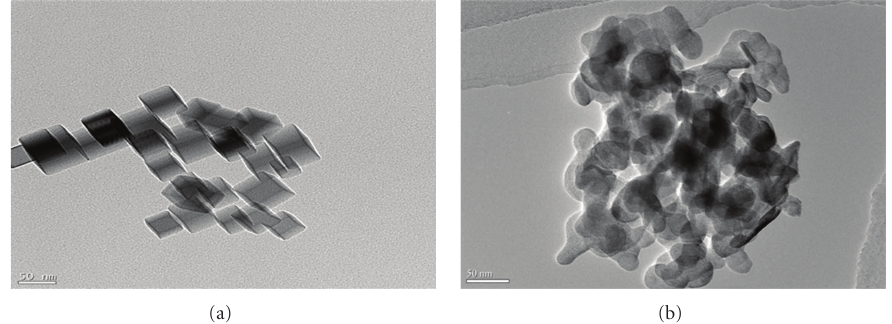
Figure 4: TEM images of CeO 2 -SiO 2 samples prepared by (a) 30 min di ff erent irradiation times and (b) hydrothermal method.